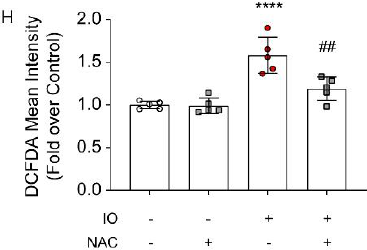
Figure 1. Characterization of intracellular iron and oxidative stress due to iron overload in H9c2. ( A ) Time-course of live-cell confocal imaging examining intracellular iron in H9c2 cells, using Fer- roOrange and Hoechst nuclear dye (blue). Cells were treated with 100 µM FeSO 4 concurrently with FerroOrange dye (1 µM) and Hoechst (100 nM). ( B ) Fluorescence mean intensity of FerroOrange in IO or control was measured at 5 min intervals and calculated as the fold over Control at t1 (5 min time point) for both conditions (n = 4). ( C – E ) H9c2 were cultured in 6-well plates and cultured with 100 µM FeSO 4 , or not (Control), for 24 h. ( C ) Quantification of Ferritin Heavy and ( D ) Light chains mRNA (normalized to 18S rRNA) and ( E ) mito-Ferritin mRNA (normalized to 18S rRNA), pre- sented as fold over Control (n = 6). ( F ) Time-course of live-cell confocal imaging examining ROS production under IO (100 µM FeSO 4 ), using CellROX Deep Red (Red) and Hoechst to stain nuclei (blue). NAC (500 nM) was used as a ROS inhibitor added 30 min prior to the start of IO. ( G ) Fluo- rescence mean intensity of CellROX Deep Red was measured at 5 min intervals and calculated as the fold over control at t1 (5 min time point) for all conditions (n = 4). ( H ) Quantification of ROS production under IO (4-h) with DCF-DA ROS dye (see Methods). NAC was used as a ROS inhibitor added 30 min prior to IO treatment (n = 5). Scale bars in B and G denotes 50 µm. * p < 0.05, *** p < 0.001, **** p < 0.0001 relative to Control; # p < 0.05, ## p < 0.01 relative to IO.